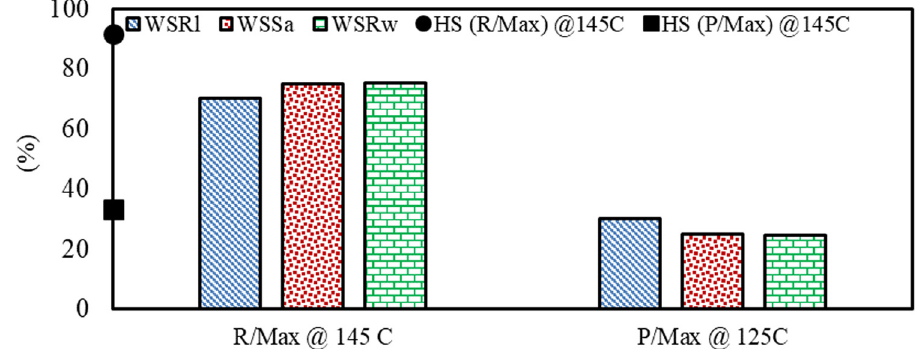
Figure 24: Final percentages of recovered and permanent strain at the termination of the second